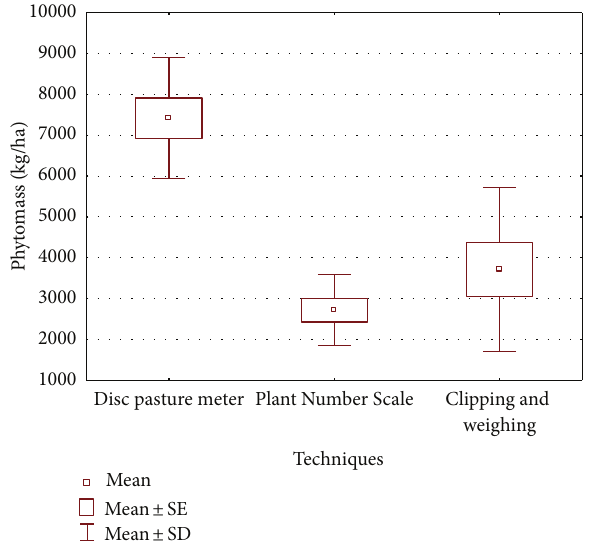
Figure 2: Mean, mean ± SE, and mean ± SD of phytomass for all three techniques at survey site